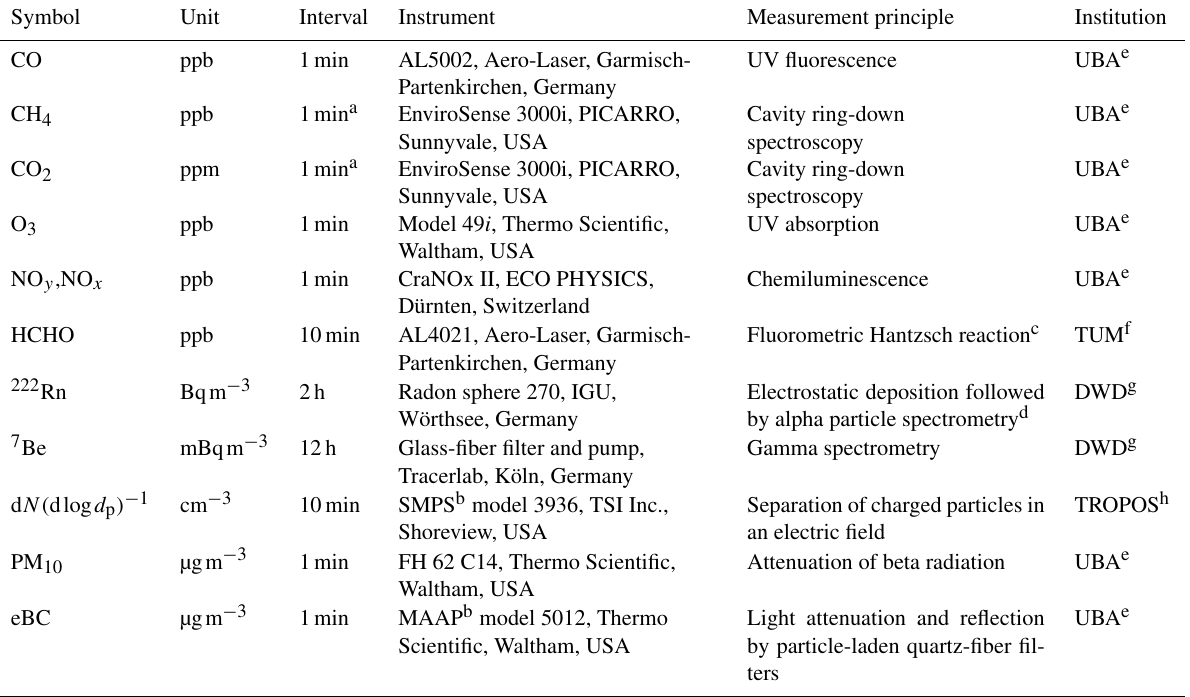
Table 1. Chemical measurements used in this study. The given interval is the temporal interval at which the data were provided by the respective institutions. UV denotes ultraviolet light. The symbols for the measured quantities are explained in the main text. Symbol Unit Interval